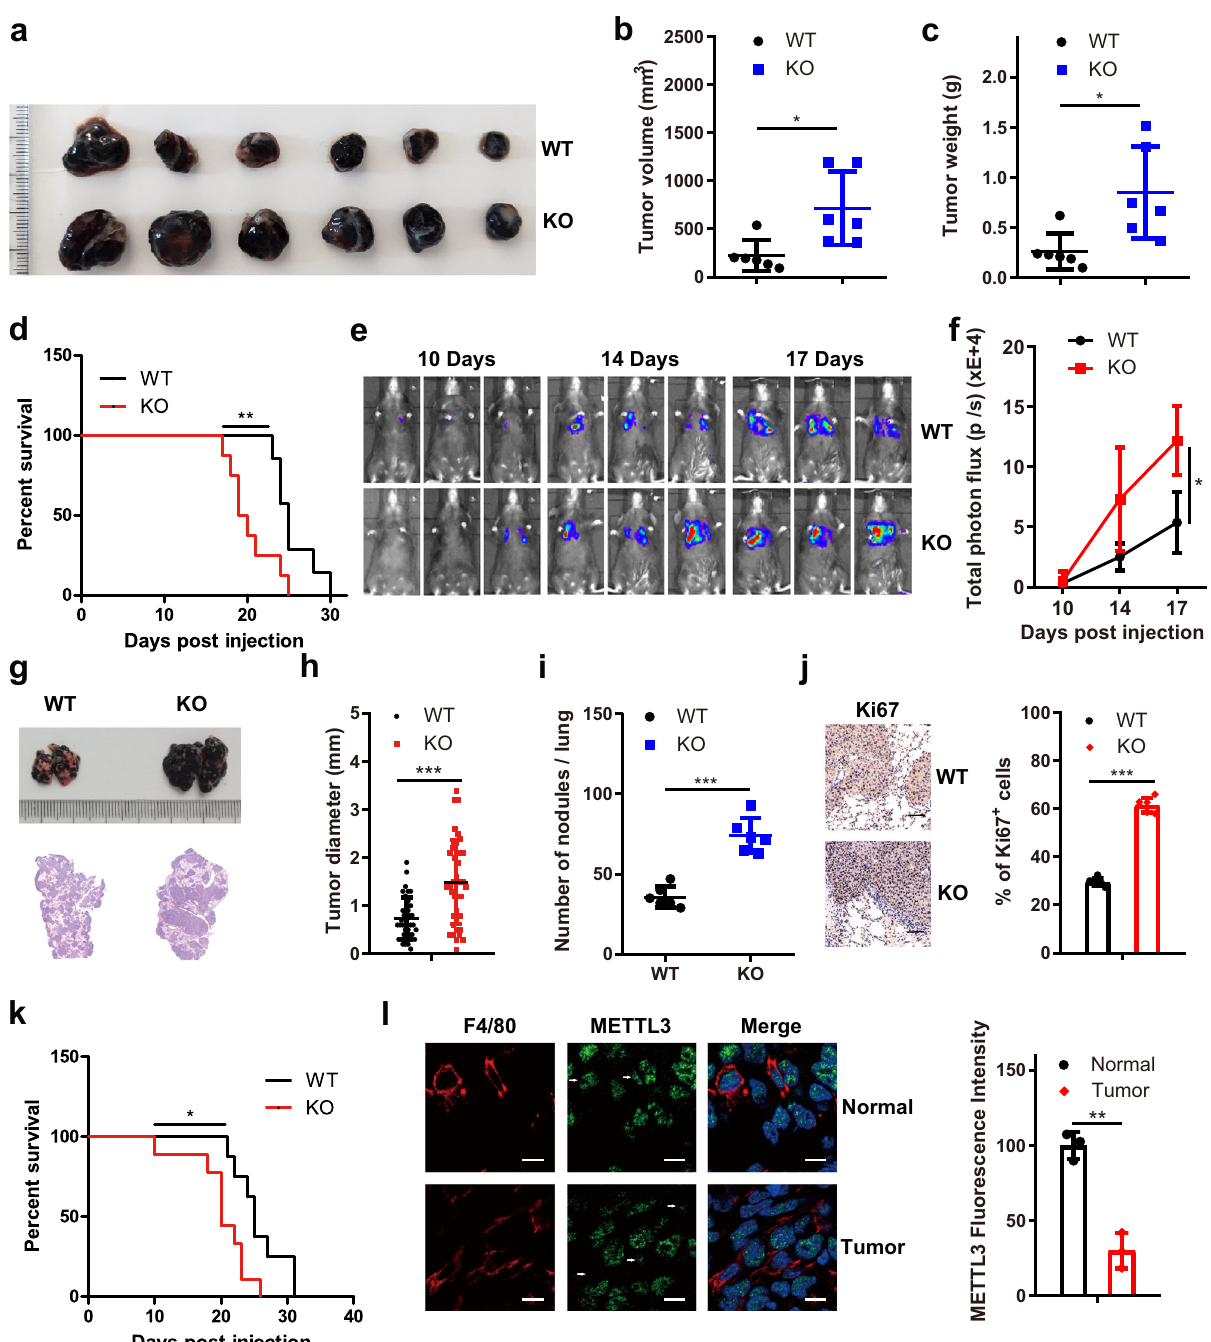
Fig. 1 Myeloid-speci fi c deletion of Mettl3 in mice promotes B16 tumour growth and lung metastasis. a – d B16 cells were subcutaneously injected into WT and Mettl3 -null (KO) mice. B16 tumours were dissected and photographed ( a ). Tumour volume ( b ) ( n = 6 mice per group), tumour weight ( c ) ( n = 6 mice per group) and mouse survival ( d ) were recorded (WT group, n = 7 mice; KO group, n = 8 mice). e , f In vivo imaging of mice was conducted following intraperitoneal administration of a substrate (D-luciferin). Representative fl uorescence images are shown ( e ) and were quanti fi ed ( f ) ( n = 3 mice per group). g Representative images of tumours in mice injected with B16 tumour cells via the tail vein (upper panel) and representative HE staining images of lung sections (lower panel) are shown. h , i Quanti fi cation of the lung tumour diameter ( h ) and metastatic nodules ( i ) of the mice evaluated in ( g ) ( n = 6 mice per group) was performed. j Representative Ki67 staining images of tumour sections are shown (left panel). Quanti fi cation of Ki67 expression was performed (right panel) ( n = 5 mice per group). Scale bars: 100 μ m. k The survival of mice injected with B16 tumour cells via the tail vein was documented ( n = 8 mice per group). l Immuno fl uorescence staining for F4/80 and METTL3 was performed to analyse expression in normal and tumour tissues (left panel). Quanti fi cation of the expression of METTL3 in macrophages was performed (right panel). The white arrows highlight F4/80 + cells (n = 3 mice per group). Scale bars, 10 μ m. Data are expressed as the mean ± SD. P values were determined by a two-tailed t -test ( b , c , f , h , i , j and l ) and the Gehan – Breslow-Wilcoxon test ( d , k ). * P ≤ 0.05, ** P < 0.01 and *** P < 0.001. The source data are provided as a Source data fi